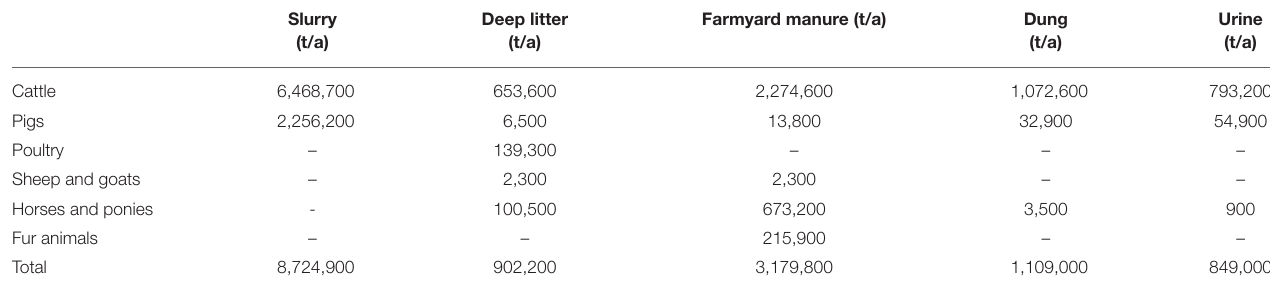
TABLE 7 | The manure quantity ex housing in Finland based on the manure data of the Finnish Normative Manure System and animal statistics of 2016.